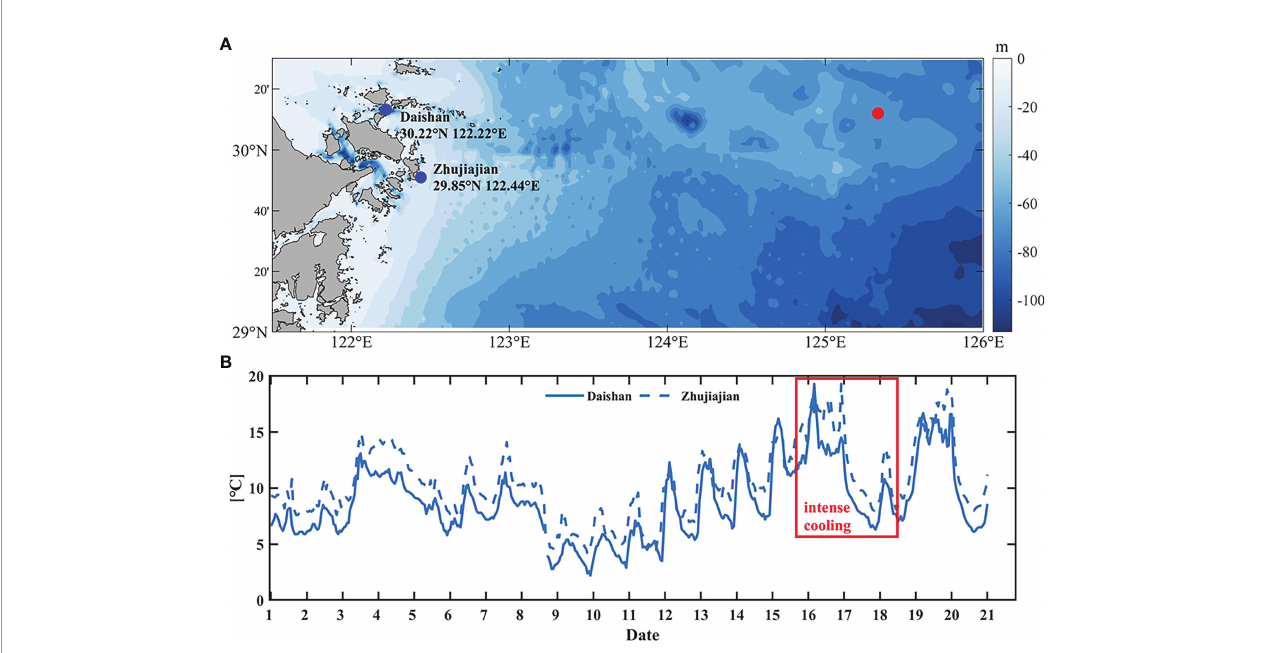
FIGURE 2 | (A) Locations of observed data stations (blue dots) and the target site (red dot). (B) Temperature variation of in-situ data at 2 stations in February 2017. The data came from Zhejiang Ocean and Fisheries